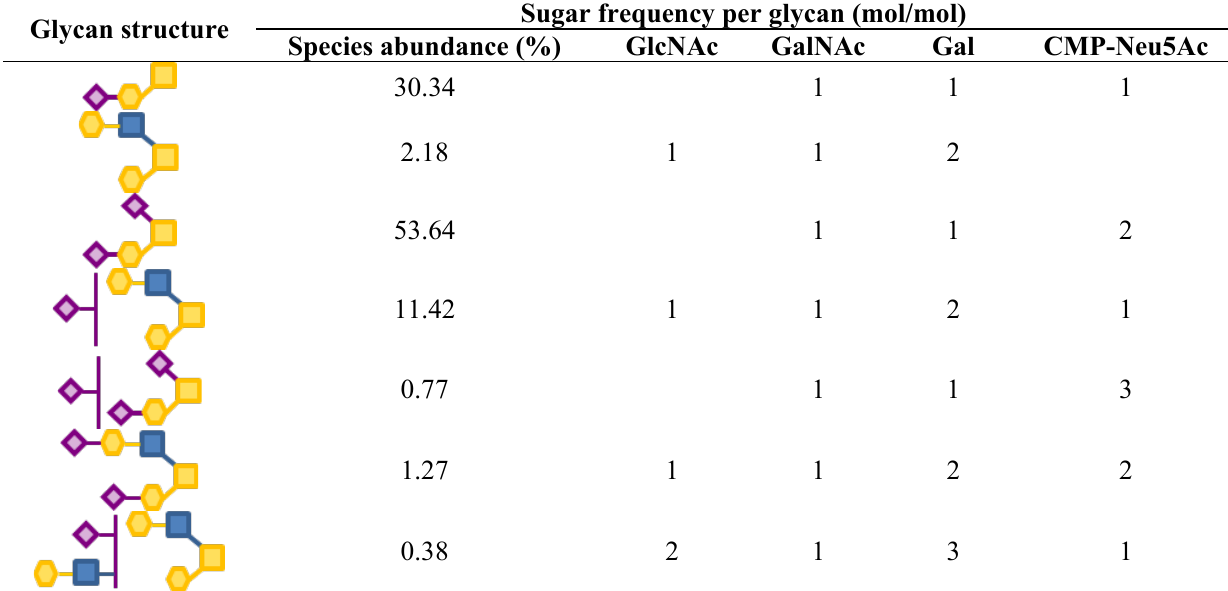
Table A2. Summary of the relative abundances of O -linked glycan structures used to obtain an average glycan structure.